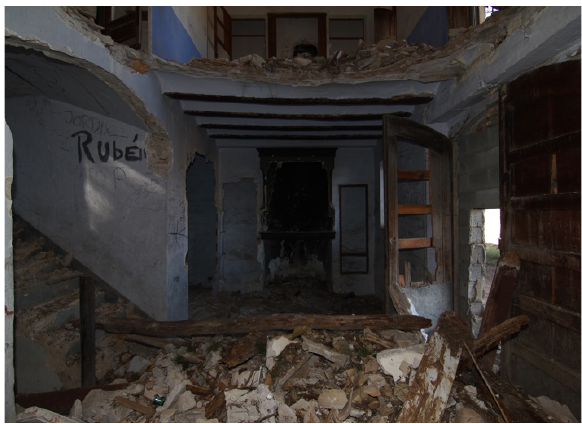
Figure 14. Ground floor with the